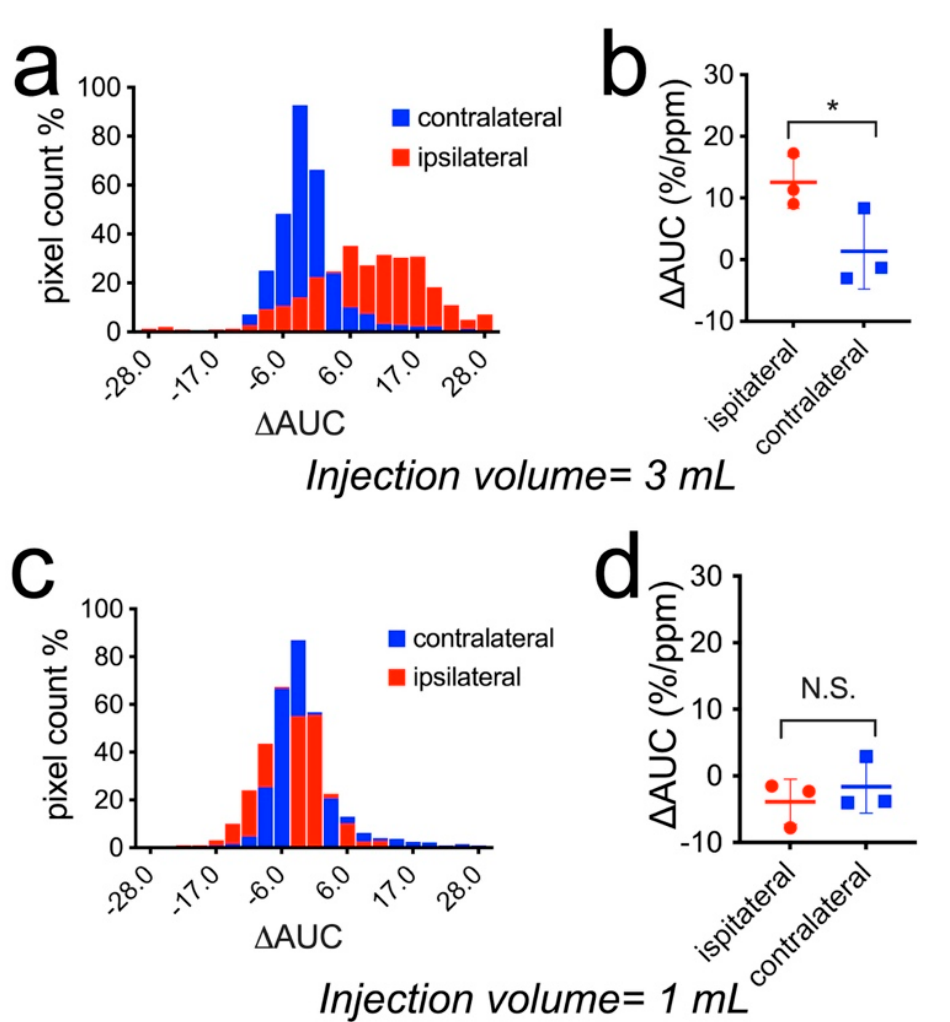
Figure 7. Comparison of the change in CEST contrast ( ∆ AUC (0.2–2.0 ppm)) in the ipsilateral and contralateral hemispheres after the injection of different doses of mannitol. ( a ) Histogram and ( b ) Mean values of three rats injected with 3 mL 25% mannitol. *: p < 0.05 ( p = 0.0105, paired two-tailed Student t -test, n = 3). ( c ) Histogram and ( d ) Mean values of three rats injected with 1 mL 25% mannitol. N.S.: not significant ( p = 0.3536, paired two-tailed Student t -test, n = 3). To accurately quantify the CEST effect in the presence of substantial T 1 changes, we also attempted to quantify the CEST contrast enhancement by mannitol using the AREX approach. Figure 8a,b show the AREX (or AREX asym ) plots in the ipsilateral and contralateral hemispheres in a rat receiving high dose mannitol. Comparing the ∆ MTR asym (0.8 ppm) maps (Figure 8c) and ∆ AREX (0.8 ppm) map (Figure 8d) reveals good agreement between the spatial distribution of ∆ CEST signal by the two methods although the CEST contrast enhancement calculated by the MTR asym method (i.e., 0.021 ± 0.003 vs. 0.054 ± 0.008 for pre- and post-mannitol, respectively, corresponding to an increase of 157% in CEST contrast) was higher than that by the AREX method (i.e., 0.318 ± 0.07 vs. 0.477 ± 0.05 for pre- and post-mannitol, respectively, corresponding to an increase of 50% in CEST contrast), attributed to T 1 “contamination” in the MTR asym